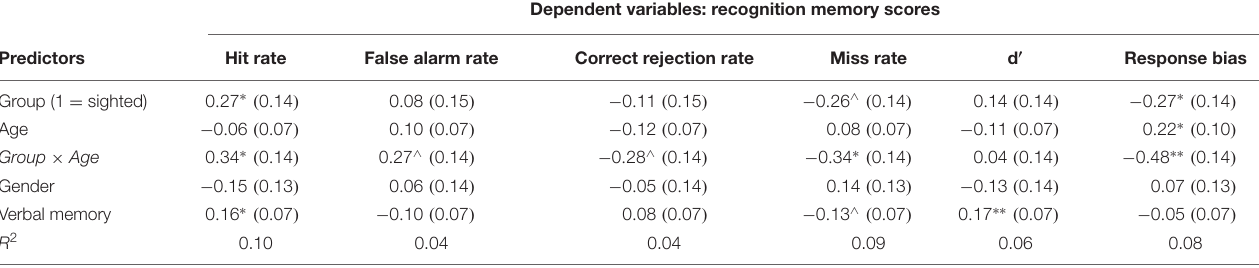
TABLE 2 | A summary of moderated regression models predicting recognition memory scores. Dependent variables: recognition memory scores